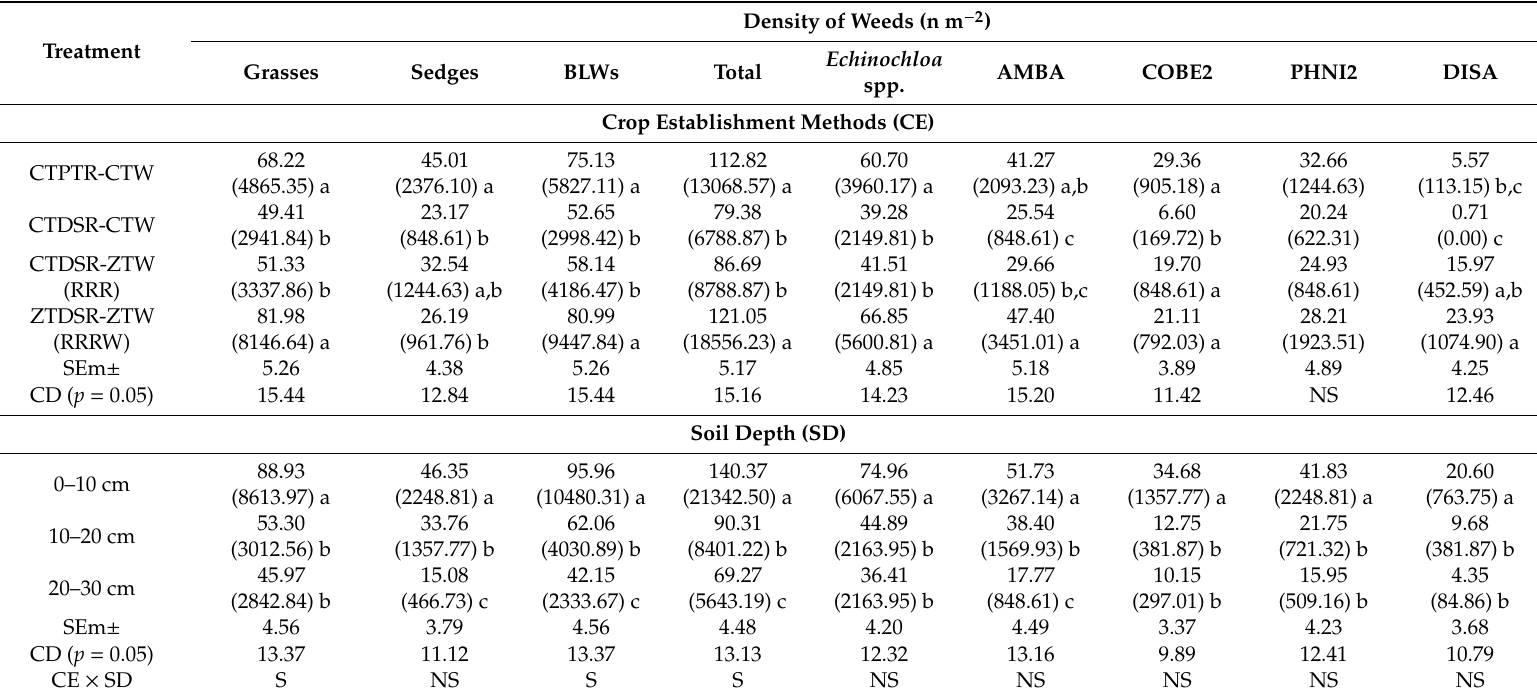
Table 4. E ff ects of di ff erent crop establishment methods and soil depth on the weed seed